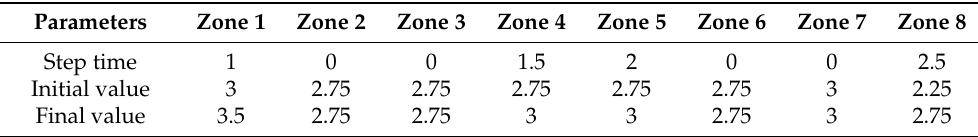
Table 1. Set points for different zones in the experiments.